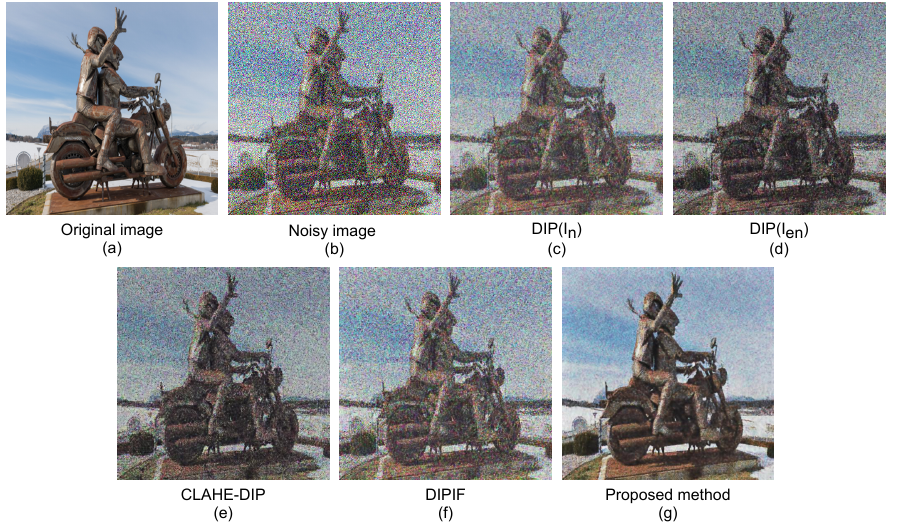
Figure 8. Noise-free images produced by our proposed method and competitive denoising methods on a “statue” image with 80% noise corruption. ( a ) Clean image, ( b ) noisy image I n , ( c ) image restored by the DIP method using the original noisy image I n for supervision, ( d ) image restored by the DIP method using enhanced noisy image I en for supervision, ( e ) image restored by the CLAHE-DIP method, ( f ) image restored by the DIPIF method, and ( g ) image restored by our proposed